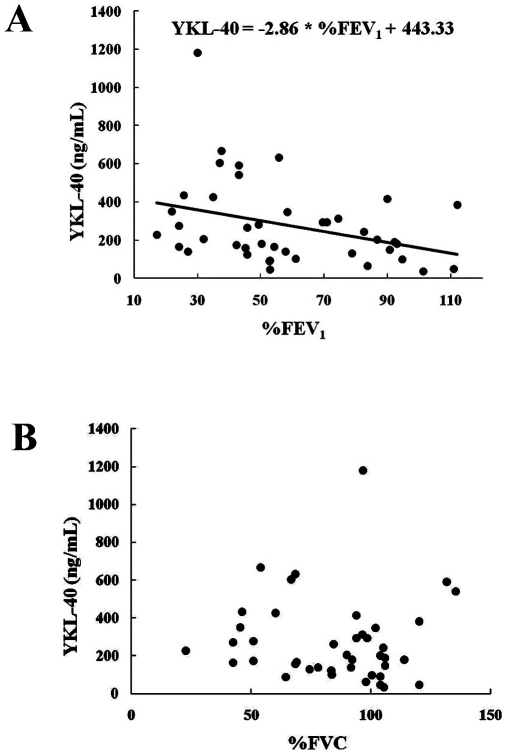
Relationship of serum levels of YKL-40 with %FEV1 and %FVC in COPD patients.Serum YKL-40 levels and %FEV1 (A) and %FVC (B) in COPD patients (n = 45) were analyzed.